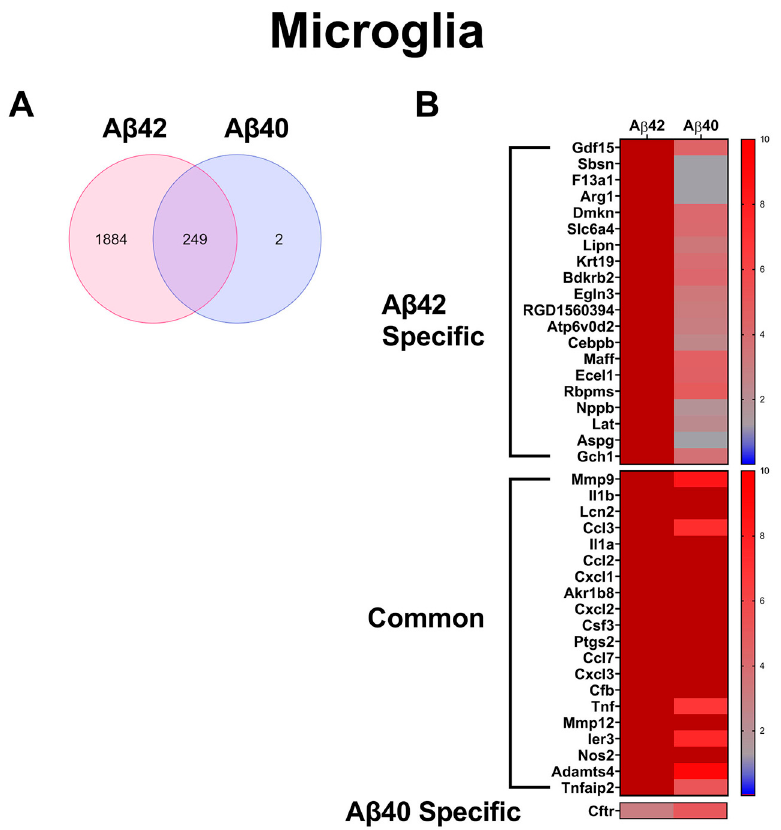
Figure 5. Significantly increased genes in primary microglia treated with A β 42 or A β 40 fibrils. ( A ) Venn diagram comparing significantly ( p < 0.05) up-regulated genes, >5-fold of untreated controls, in primary microglia treated with A β 42 or A β 40 fibrils ( n = 3). ( B ) Heat maps depicting relative expression of most enhanced genes specific to A β 42 fibril treatment, common to both A β 42 or A β 40 fibril treatments and specific to A β 40 fibril treatment, together with the corresponding expression in the other treatment groups.